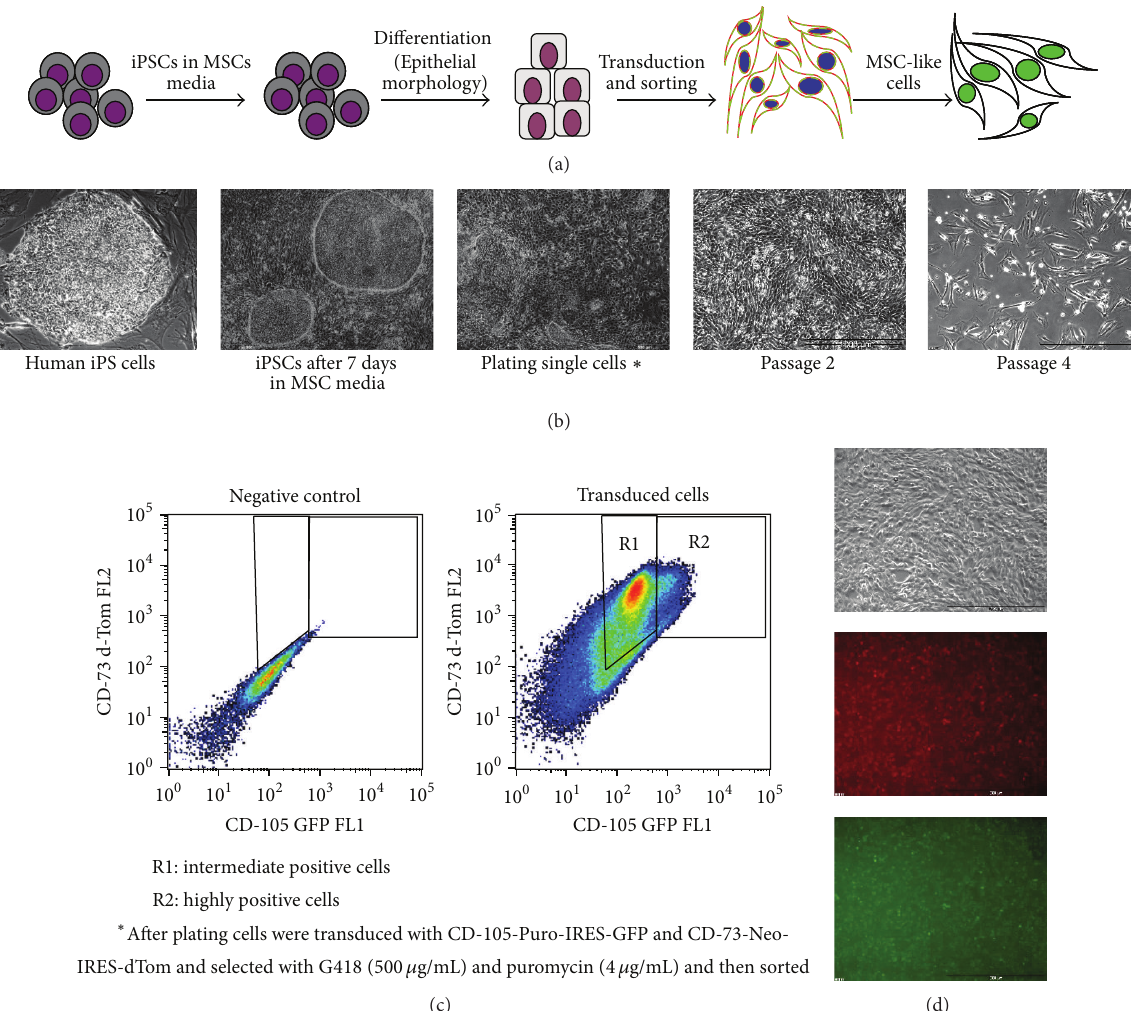
Figure 2: Derivation and enrichment of MSCs from human iPS cells. (a) Schematic stepwise protocol for differentiation and selection of MSC-like cells from human iPS cells. (b) phase-contrast photos demonstrating Epithelial-Mesenchymal transition in cellular morphology. (c) FACS dot blot showing intermediate (R1) and highly (P2) double-positive cells. Highly positive CD-73 and CD-105 (R2) were sorted